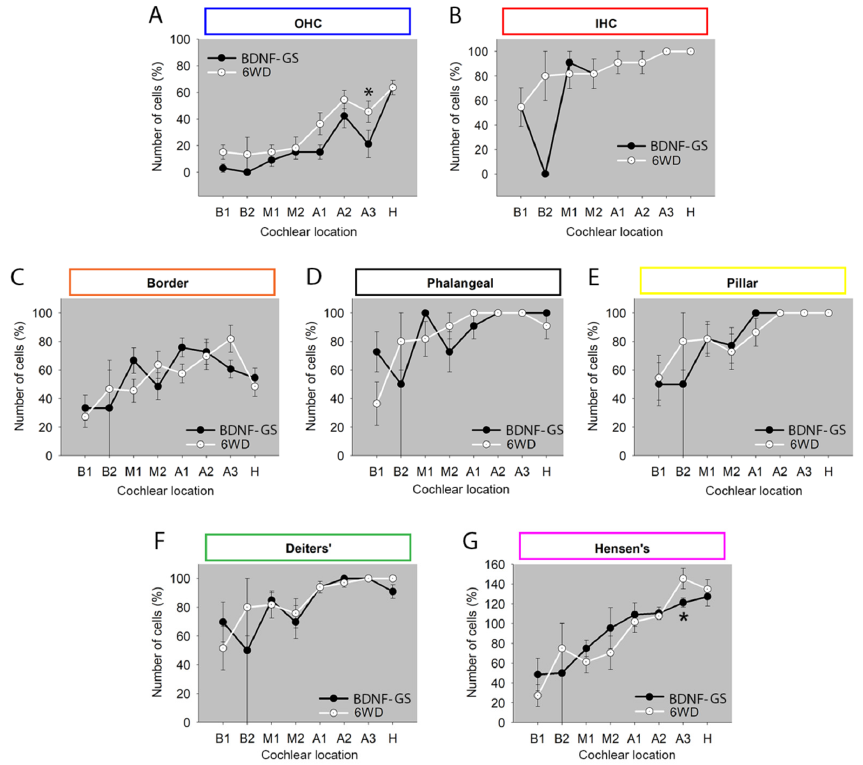
Figure 5. Cell count of sensory and non-sensory cells in the organ of Corti of BDNF-GS-treated ears over all cochlear locations. Cell count of ( A ) outer hair cells (OHC), ( B ) inner hair cells (IHC), ( C ) border, ( D ) phalangeal, ( E ) pillar, ( F ) Deiters’, ( G ) Hensen’s cells. Graphs are shown as mean ± SEM (n = 11) and show cell count of each cell type for each cochlear location of BDNF-GS and untreated ears (6WD). * p < 0.05, statistical analysis: Mann Whitney. Number of cells is expressed as percentage of NH (100%).